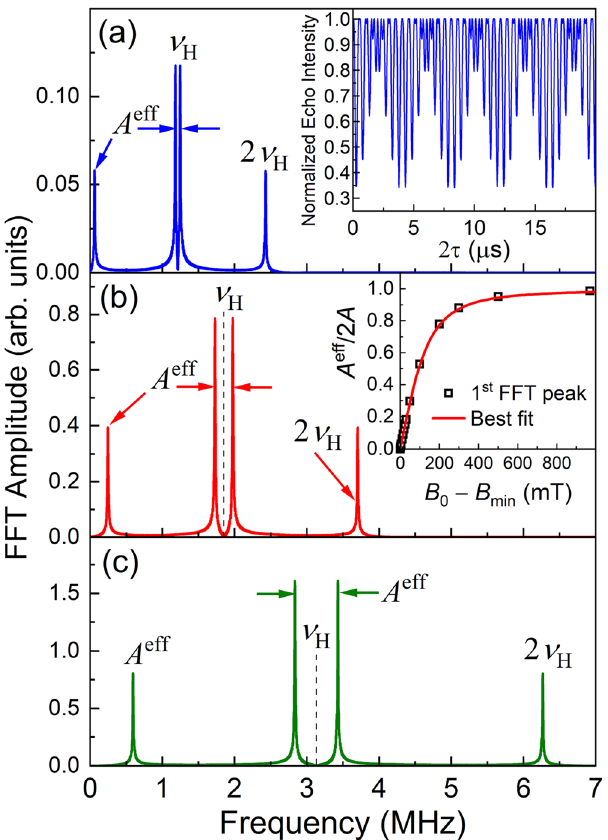
Fig. 3 Simulated ESEEM spectra for N = 1. FFTs of Hahn echo simulations for the simple case of a single I ¼ 1 proton coupled to a central S = 1 2 electron spin for different detunings, B 0 (cid:2) B min = + 5mT ( a ), + 20mT ( b ), and + 50mT ( c ); see text for employed parameters. Several relevant frequencies are labeled in the FFT spectra. The inset to a shows a representative electron spin-echo intensity time trace. The inset to b plots A eff deduced from the fi rst FFT peak versus B B 0 (cid:2) min (error bars corresponding to± s.d. are considerably smaller than the data points and are not shown); the solid red curve is a simple fi t that assumes A eff ∝ d f /d B 0 from Fig.